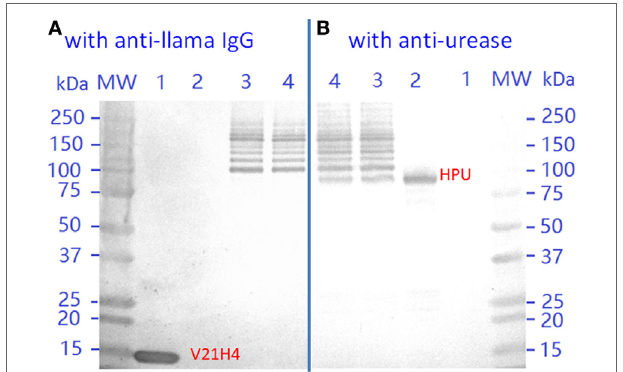
FigUre 7 | Western blot of V21H4, high purity urease (HPU), and V21H4-DOS47. Blots were probed with (a) an anti-llama antibody or (B) an anti-urease antibody. Lane MW: molecular weight ladder. Lane 1: V21H4. Lane 2: HPU. Lanes 3 and 4: